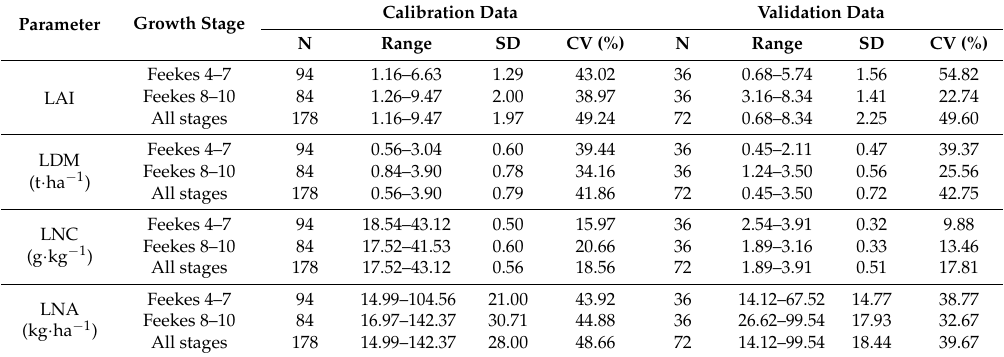
Table 2. Statistical analysis of LAI, LDM, LNC, and LNA at different growth stages across eco-sites and